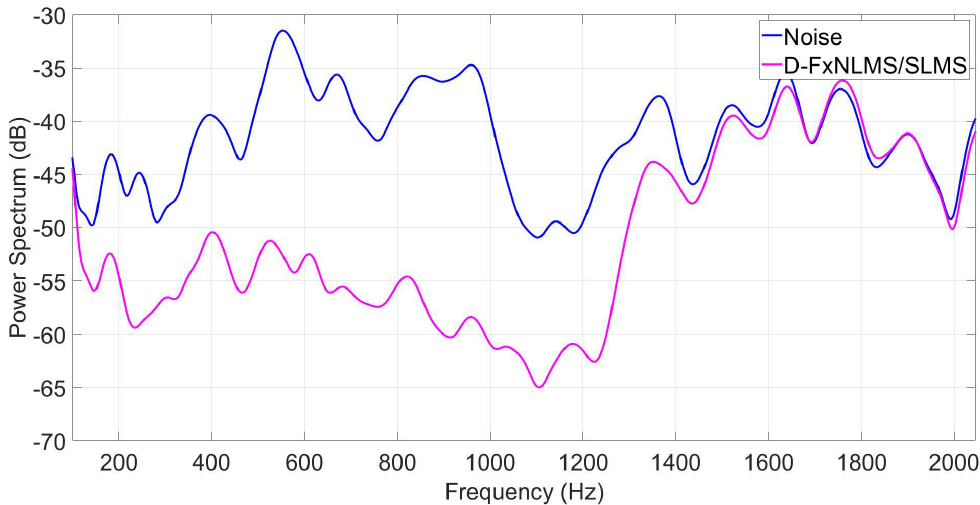
Figure 12. Power spectrum of the error signal at observation microphone by taking into account an AR(1) process as a reference signal.